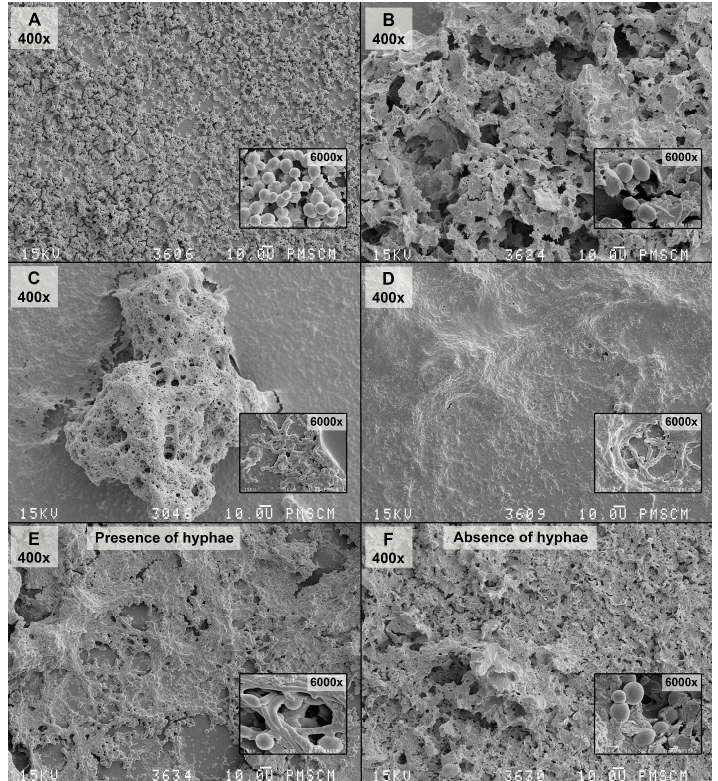
Figure 7. S. mutans , C. albicans , and oral streptococci/yeast biofilm formation: changes in optical density (OD) of biofilm mass, before and after administration of Lactobacillus salivarius (HM6 Paradens) after 24 h. Wilcoxon’s test was used for dependent (repeated) measurements (paired Wilcoxon’s test; p < 0.05). Data are represented as median ± 1–3 quartiles for three experiments. *** Indicates statistically significant difference compared to untreated biofilms ( p < 0.001).